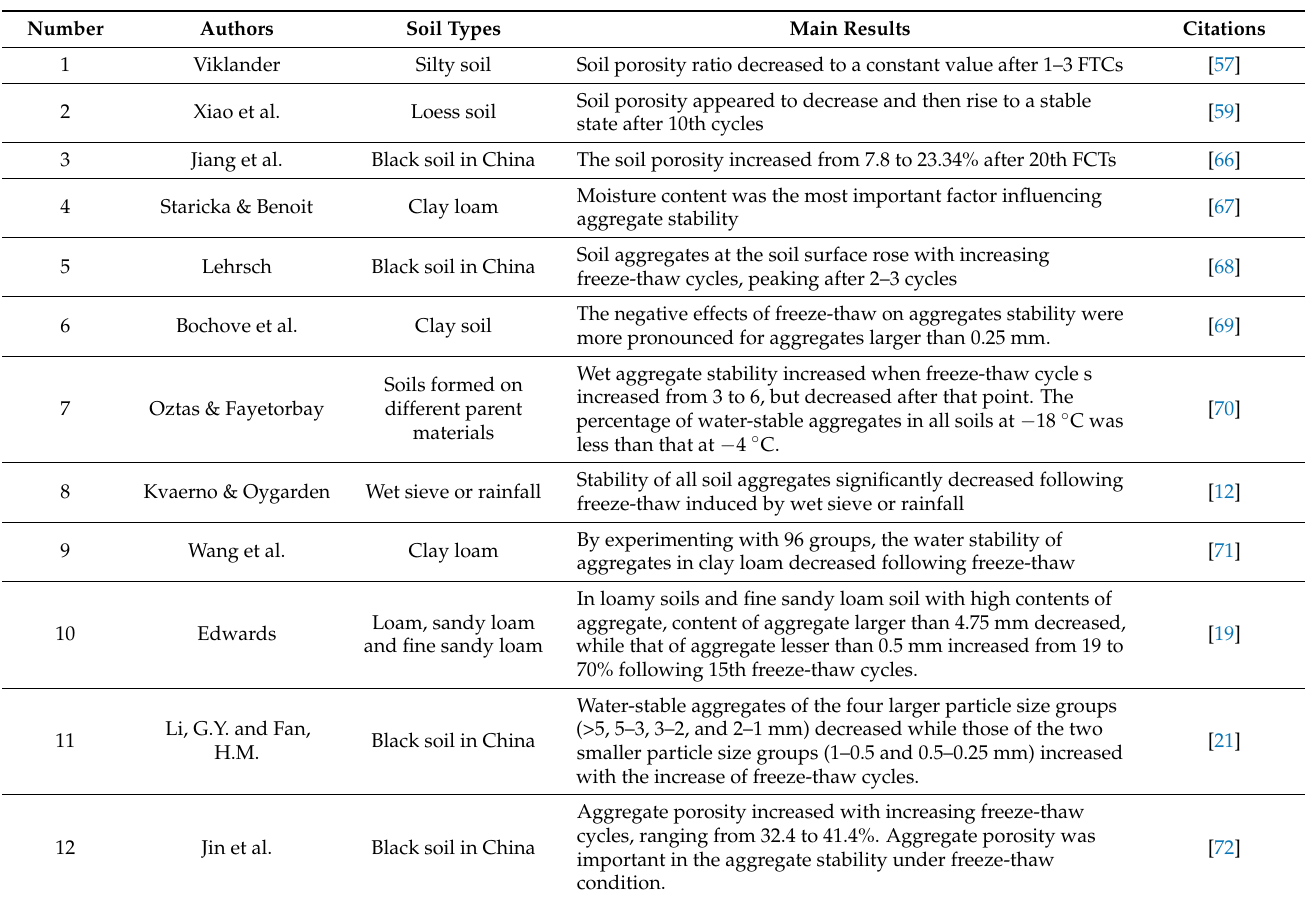
Table 1. Researches of the effect of freeze-thaw on soil structure.